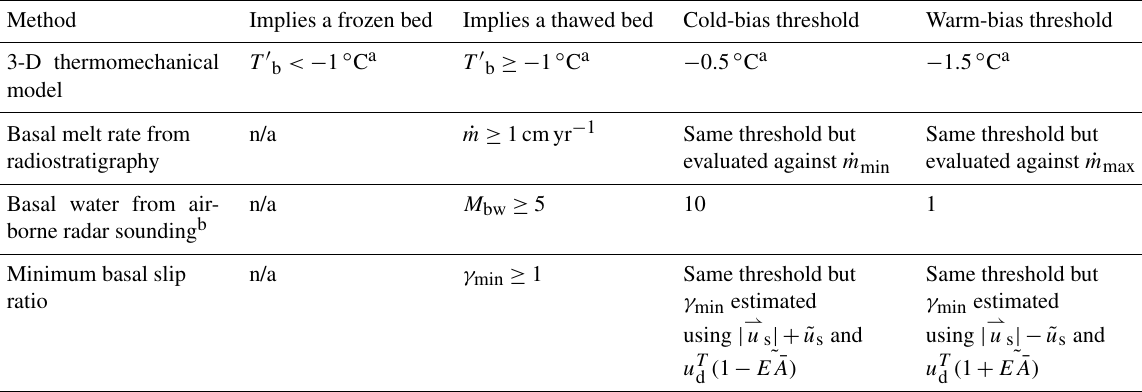
Table 3. Thresholds for inference of a particular basal thermal state. Method